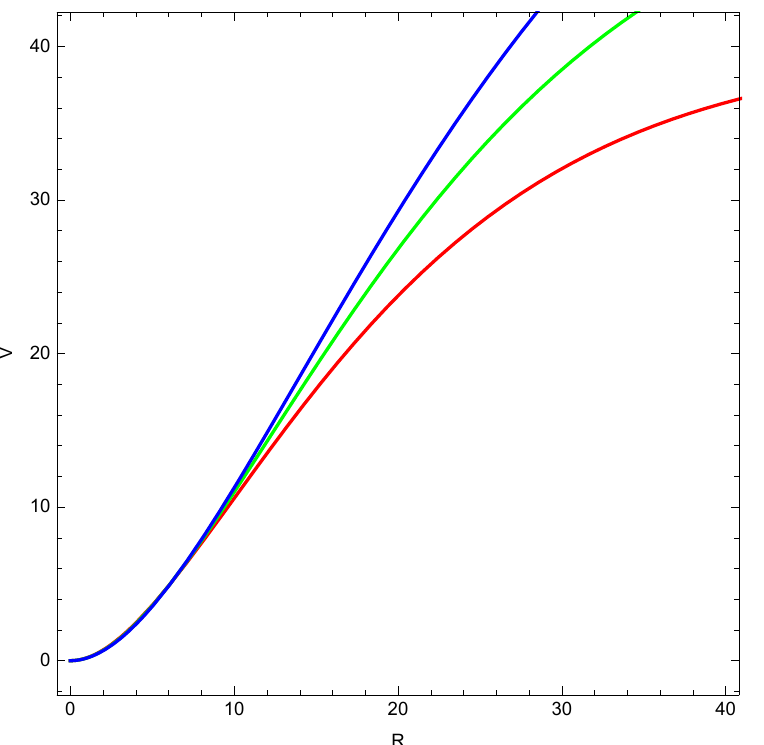
Figure 34. The evolution of V ( φ 2 ) is obtained by Equations (32) and (49). The red, green, and blue lines correspond to small perturbations of R E and β ,